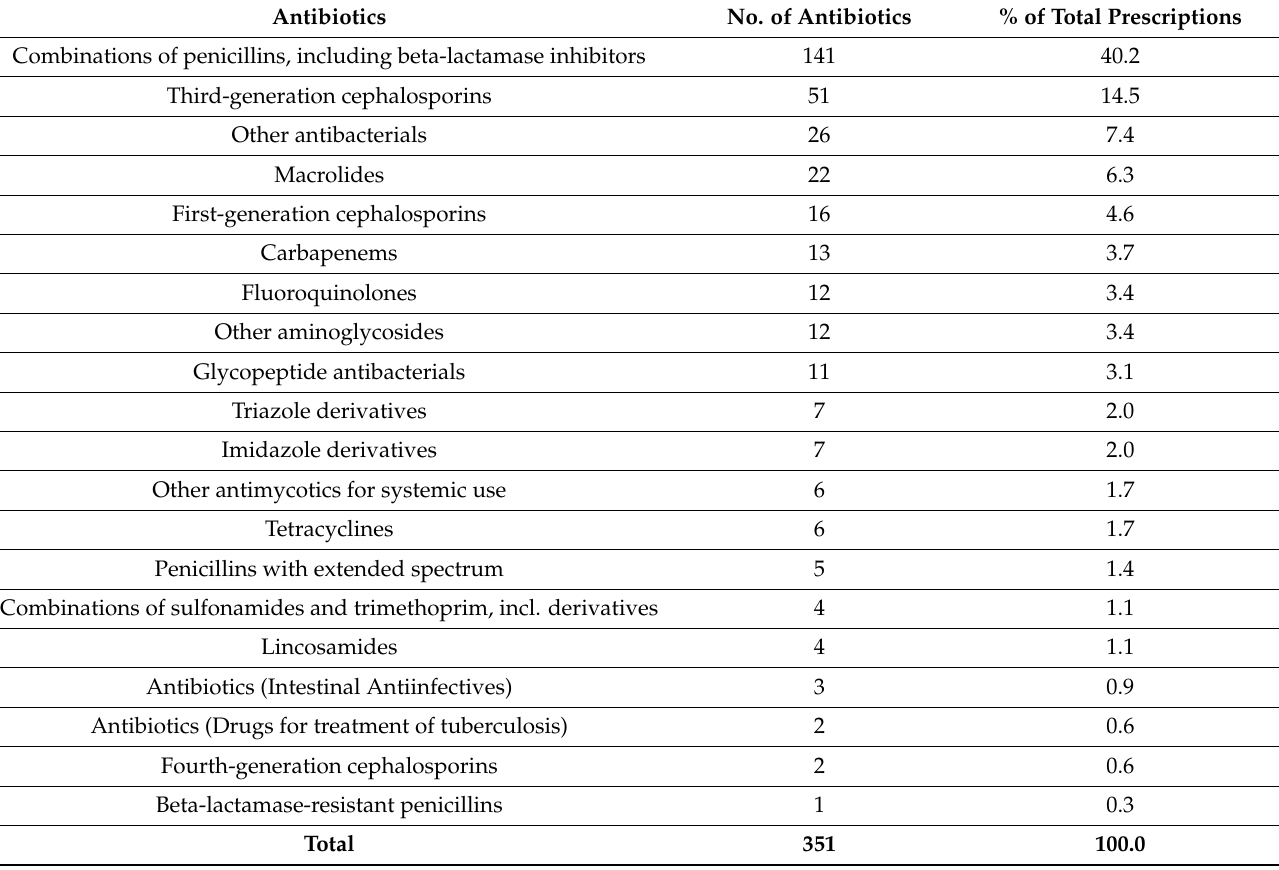
Table 6. Antimicrobials prescribed according to the pharmacological